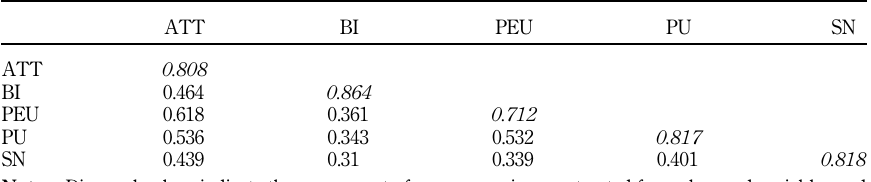
validity for the measurement